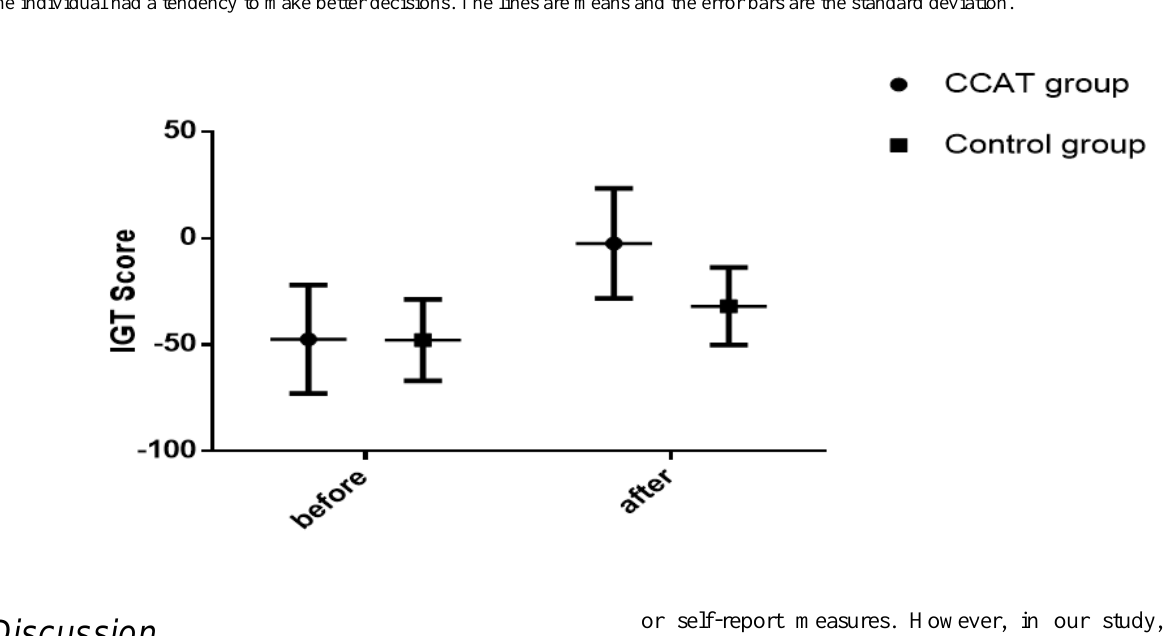
Figure 10. Iowa Gambling Task (IGT) scores after computerized cognitive addiction therapy (CCAT) or control training. The IGT score was calculated through the number of cards from the disadvantageous decks (C and D) subtracted from the advantageous decks (A and B). A positive score reflects the individual had a tendency to make better decisions. The lines are means and the error bars are the standard